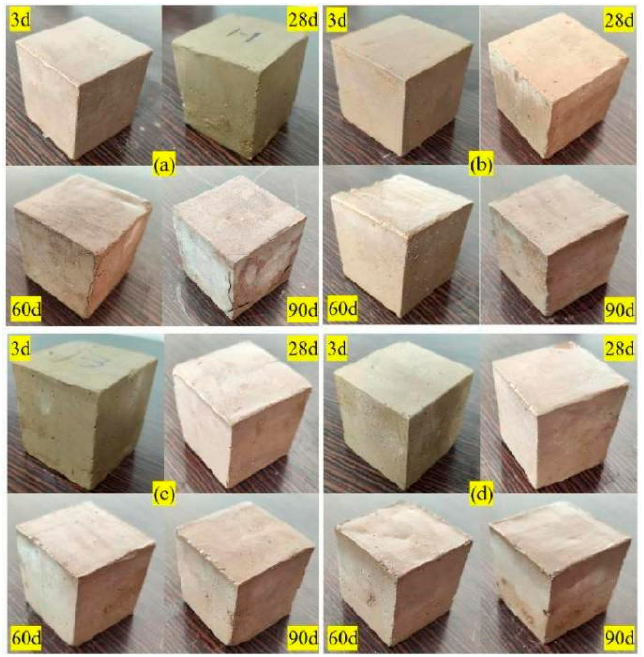
Figure 2. Visual appearance of SF-GSSS immersed in Na 2 SO 4 solution: ( a ) S10F0; ( b ) S9F1; ( c ) S8F2; and ( d ) S7F3.